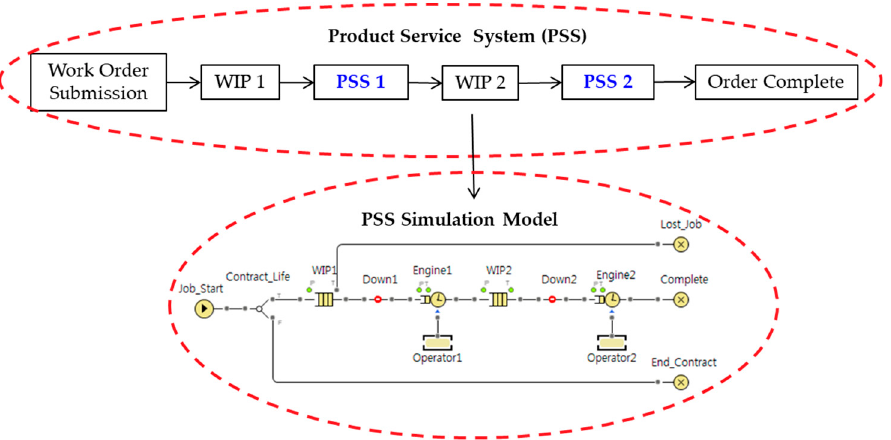
Figure 1. Simulation model flow chart for industrial printing product service system.